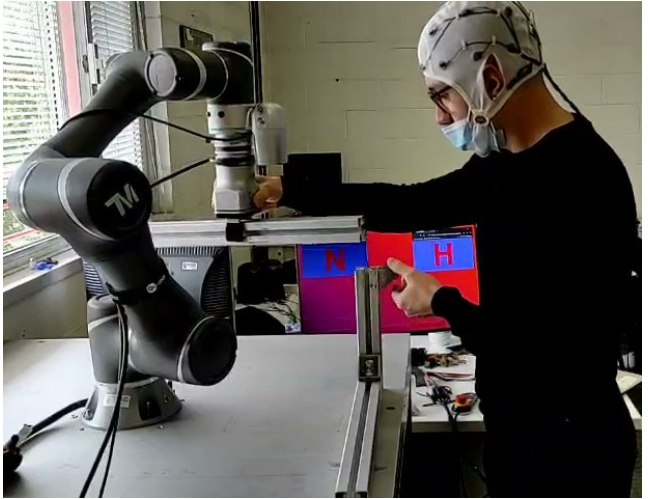
Figure 10. Step 4 of the assembly task. Supportive phase with hand